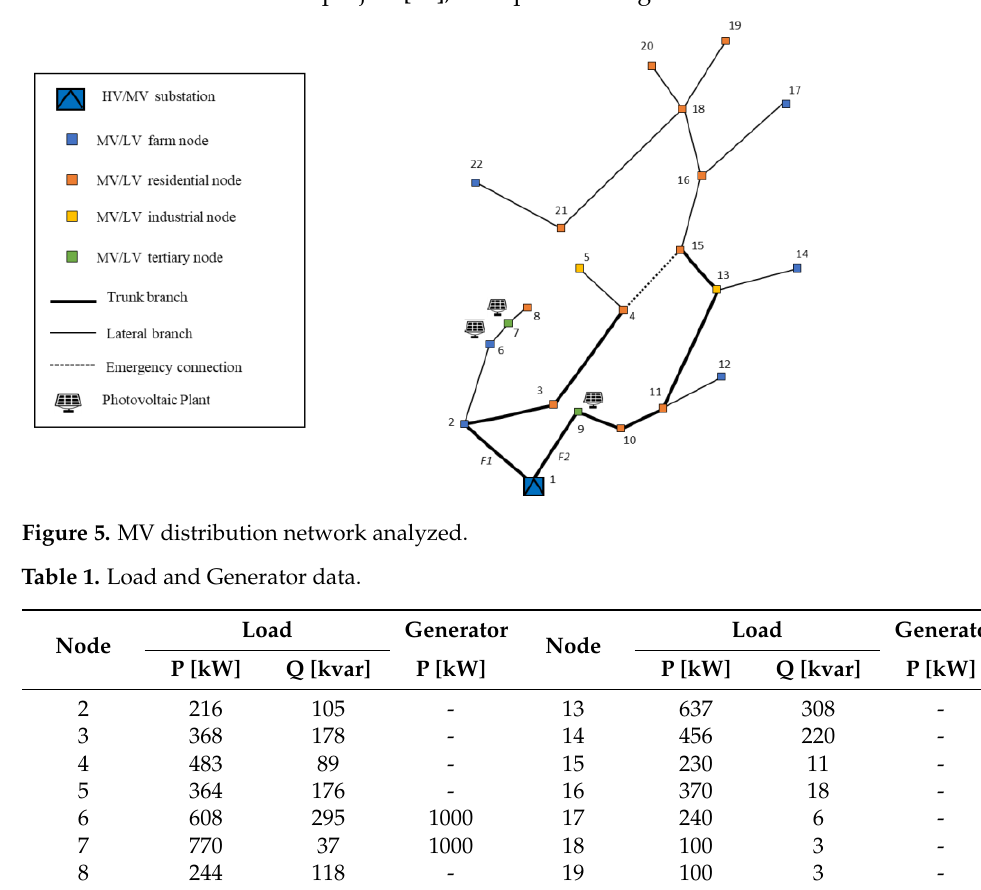
Table 1. Load and Generator data.